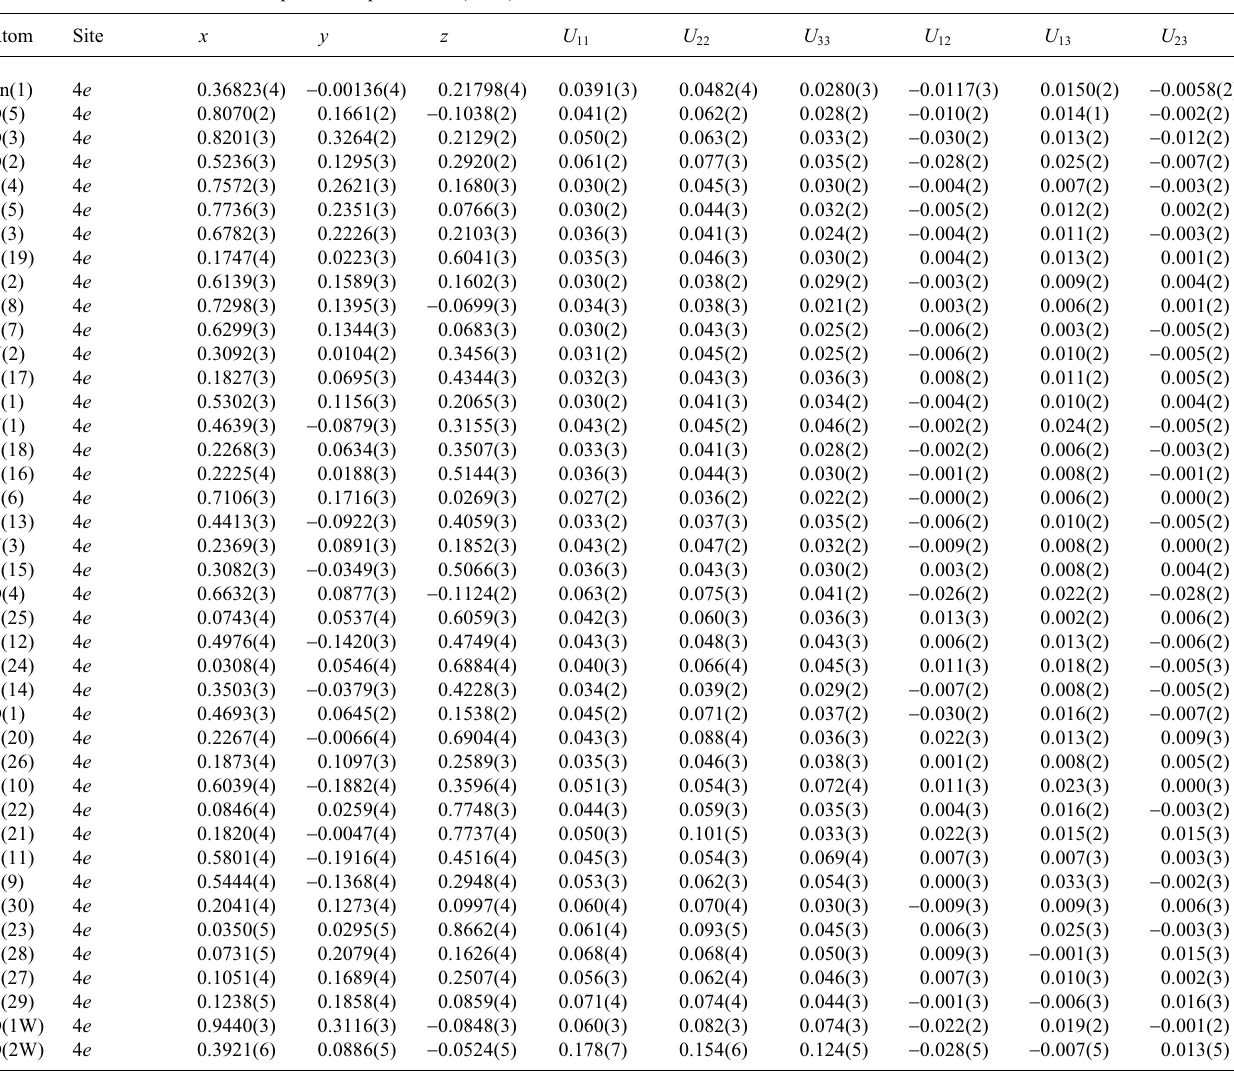
Table 3. Atomic coordinates and displacement parameters (in Å 2 ).